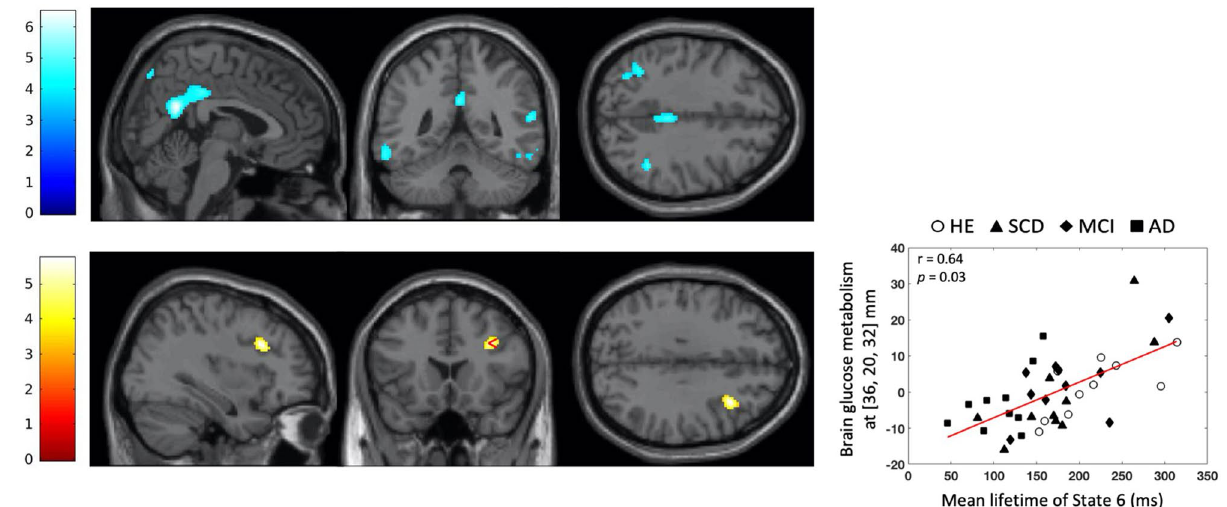
Figure 3. Statistical parametric T maps showing a significant reduction in regional glucose consumption in AD patients compared with healthy elders (Top) and a significant positive correlation between mean lifetime of State 6 and regional glucose consumption across the 40 participants with group as covariates of no interest (Bottom). Images are thresholded at p < 0.001 uncorrected with a cluster threshold at 100 voxels for visualization purpose. The color scales represent the T-statistic of the significant